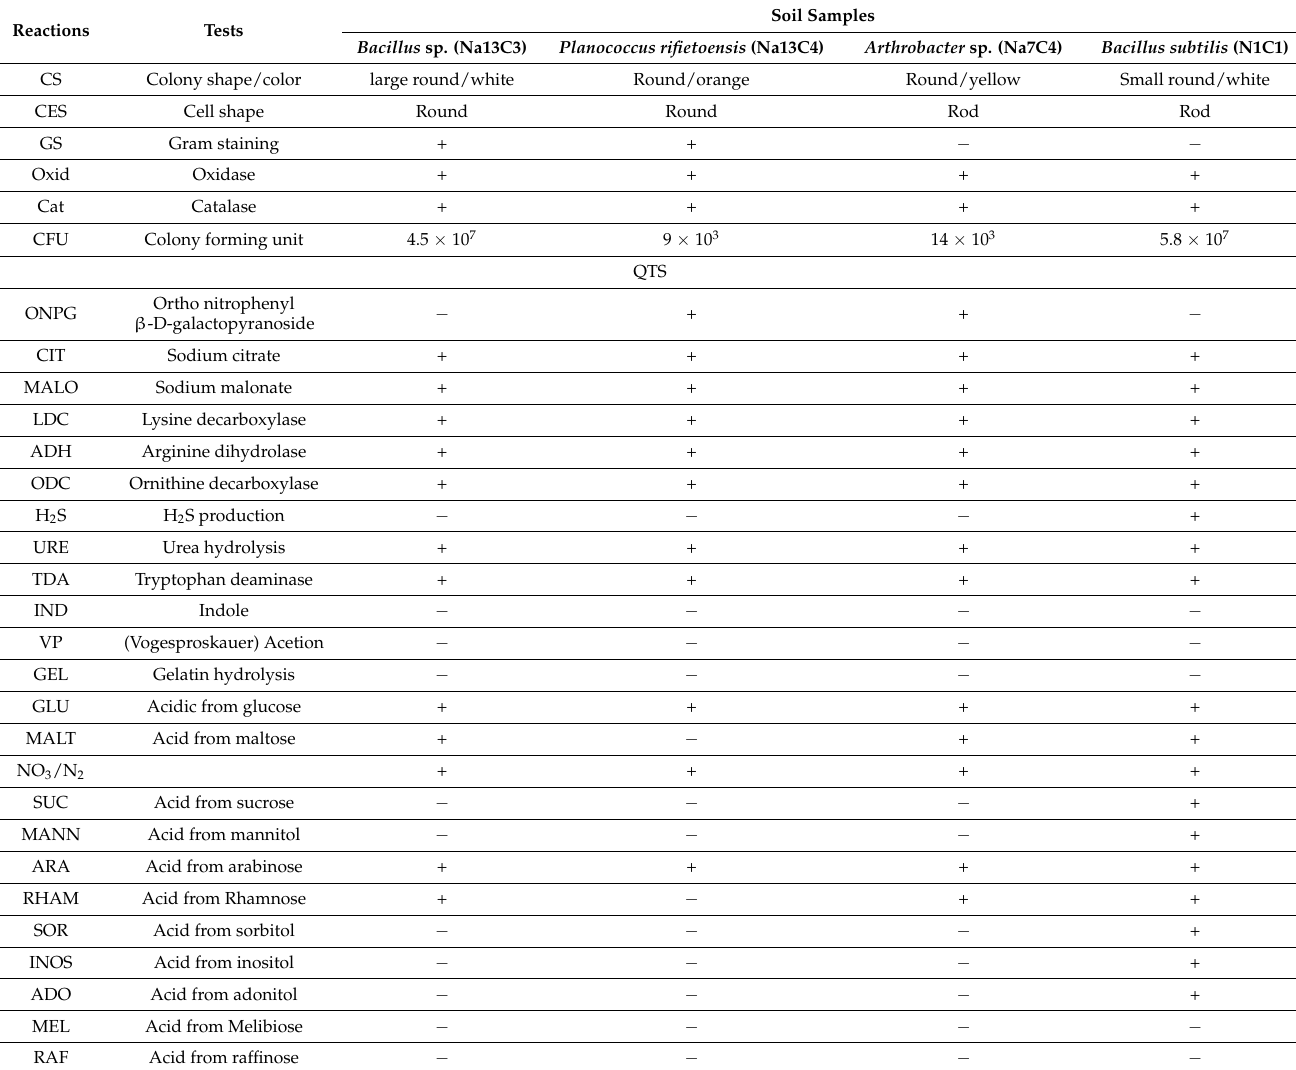
Table 1. Morphological and biochemical characterization of isolated microbial strains from the soil samples taken at three different altitudes in Gilgit Baltistan, Pakistan. Microbial identification kits QTS-24 from Desto Laboratory, were used for biochemical tests.